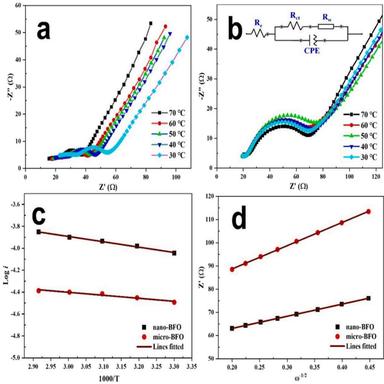
EIS data: (a) SM-BFO and (b) micro-BFO; The derived relationship between (c) Log (i) vs. 1000/T and (d) Z′ vs. ω−1/2.